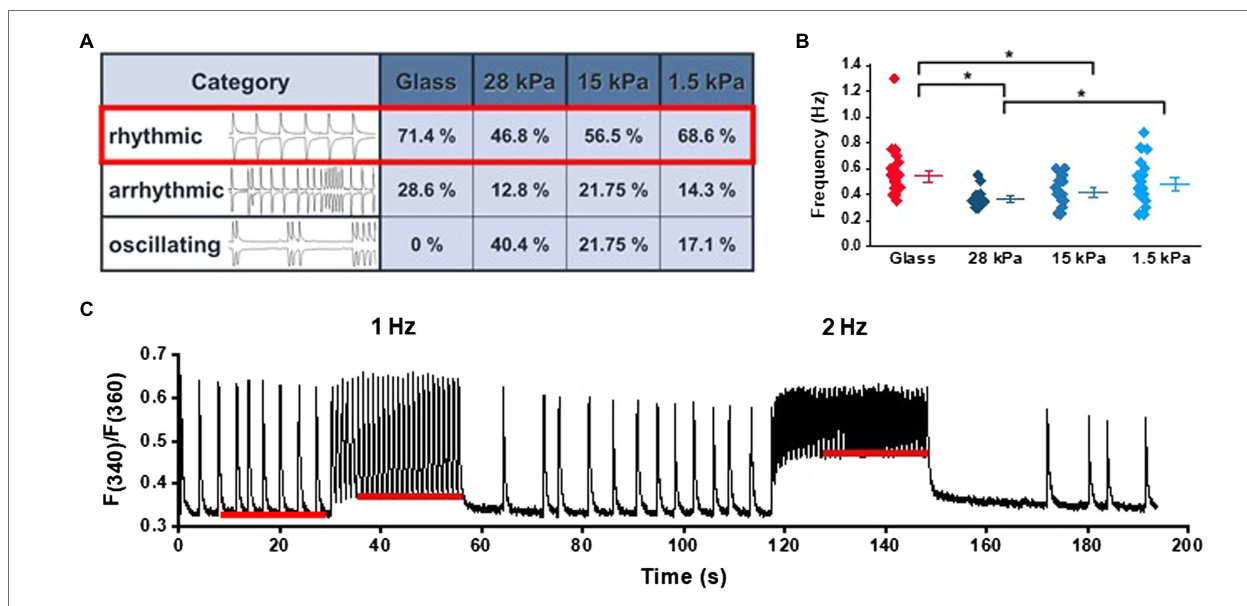
FIGURE 1 | Ca 2+ signaling in iPSC-CMs grown on substrates with different stiffnesses during spontaneous activity and electrical pacing. (A) Categorization of different phenotypes of spontaneous activity ranging from rhythmic, arrhythmic to oscillating activity patterns in cells grown on surfaces with different stiffnesses ( n = 42 on glass, n = 47 on 28 kPa-PDMS, n = 44 on 15 kPa-PDMS, and n = 35 on 1.5 kPa-PDMS). (B) Quantification of the spontaneous beating frequency of rhythmic cells (glass: n = 30; 28 kPa-PDMS: n = 21; 15 kPa-PDMS: n = 25; and 1.5 kPa-PDMS: n = 24). (C) Sample trace of Ca 2+ transients recorded during spontaneous activity and during episodes of electrical pacing at 1 Hz or 2 Hz. The red lines illustrate frequency-dependent changes of diastolic Ca 2+